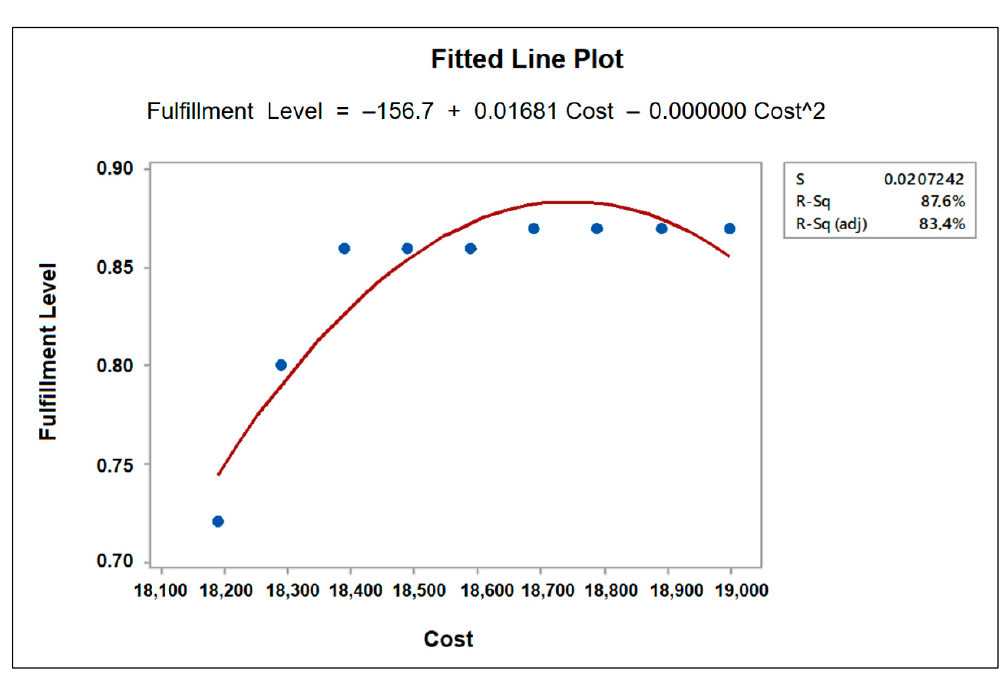
Figure 7. Fulfillment level and cost function.